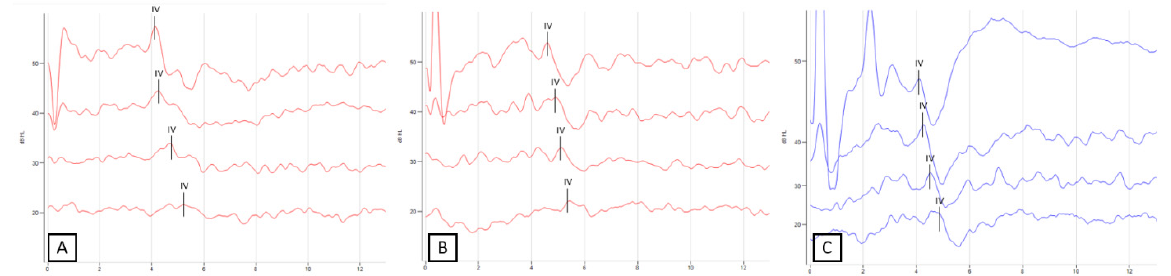
Figure 4. Representative measurement of bone conduction ABR for sonoporation side (right ear) before ( A ) and after sonoporation ( B ) and control side (left ear) ( C ) for sheep #5. Wave IV can be clearly observed and was not modified by sonoporation. Table 1. ABR thresholds of wave IV detection are presented for each sheep before and after sonopo- ration session and for control side.